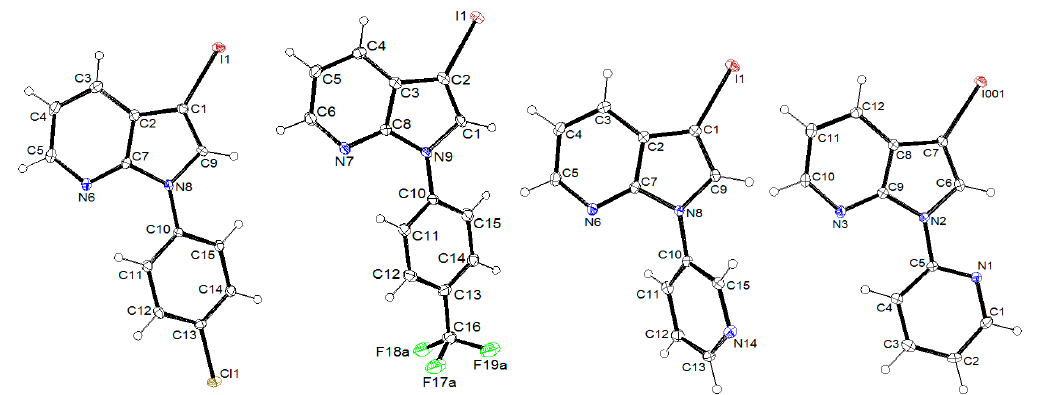
Figure 11. ORTEP diagrams (30% probability) of 4c , 4e , 4h and 4i .